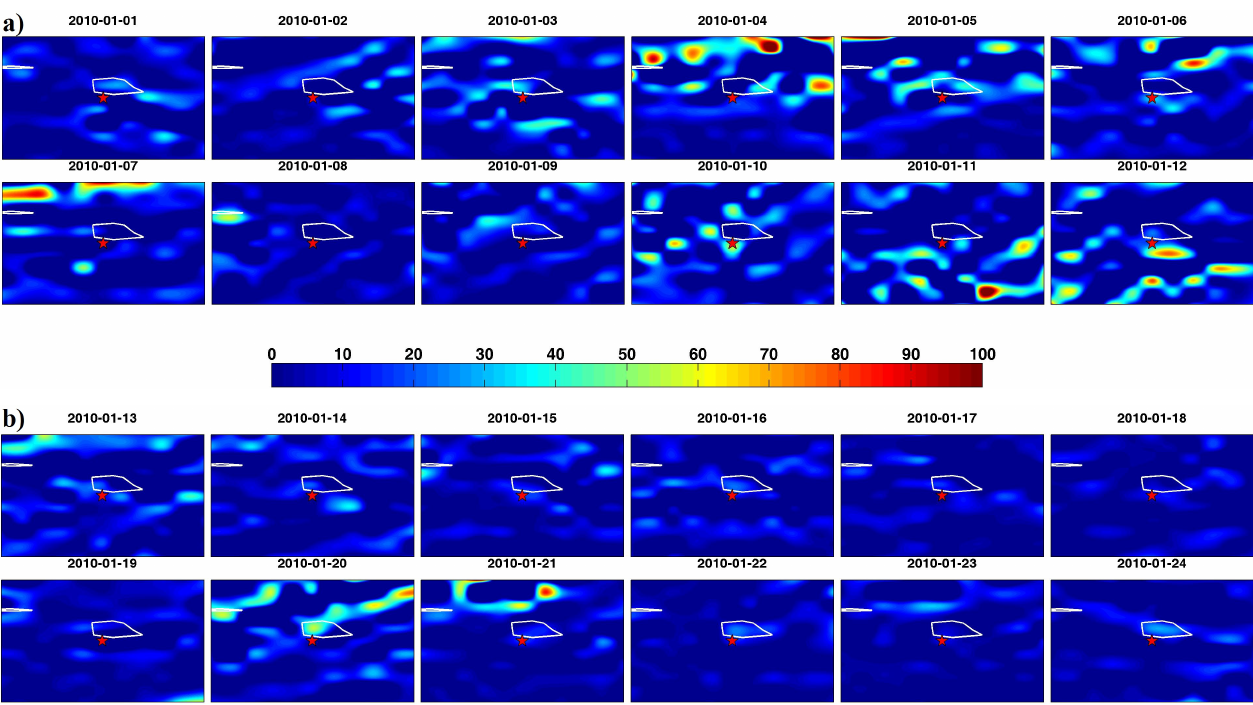
Fig. 3. Eddy field OLR (night data) curves (a) from 1 to 12 January 2010, before Haiti earthquake, (b) from 13 to 24 January 2010, after Haiti earthquake. Epicenter is marked with red star, tectonic plate boundaries with white line, Longitude from 282.5 ◦ to 292.5 ◦ , Latitude from 13.5 ◦ N to 23.5 ◦